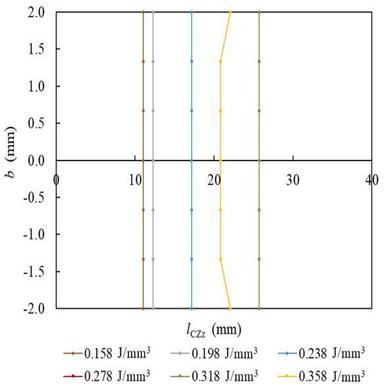
Evolution of lCZz along b of SLS test specimens depending on EDV.